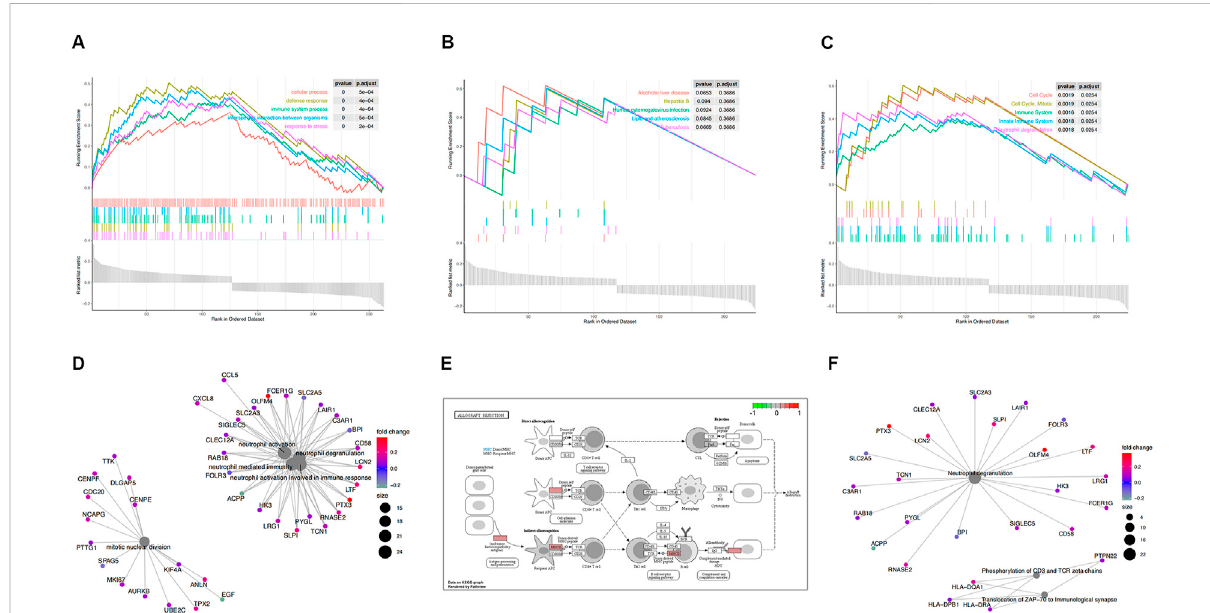
FIGURE 3 Functional enrichment analysis of GSE30718. (A) KEGG pathways enrichment analysis. (B) Gene ontology (GO) enrichment analysis. (C) Reactome enrichment analysis. (D) . emap visualizes gene ontology and gene-function relationships. (E) Signi fi cant enrichment pathways; green represents genes that have relatively low expression and red represents genes that have relatively high expression. (F) emap visualizes Reactome gene-function relationships.